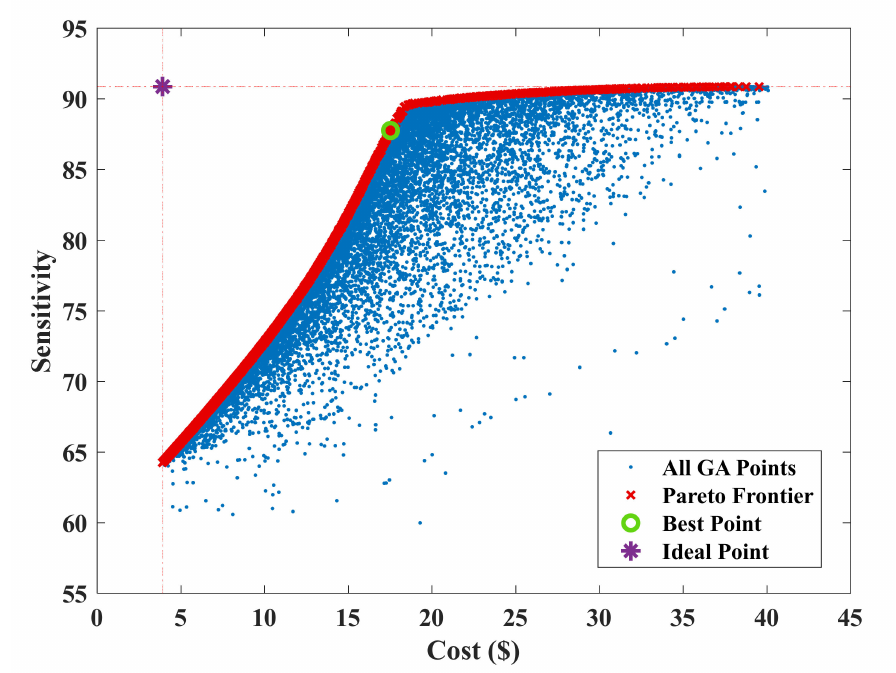
Figure 7. Pareto Frontier of cost and sensitivity as a result of optimization for nanocomposite sensor with 1.25% wt.